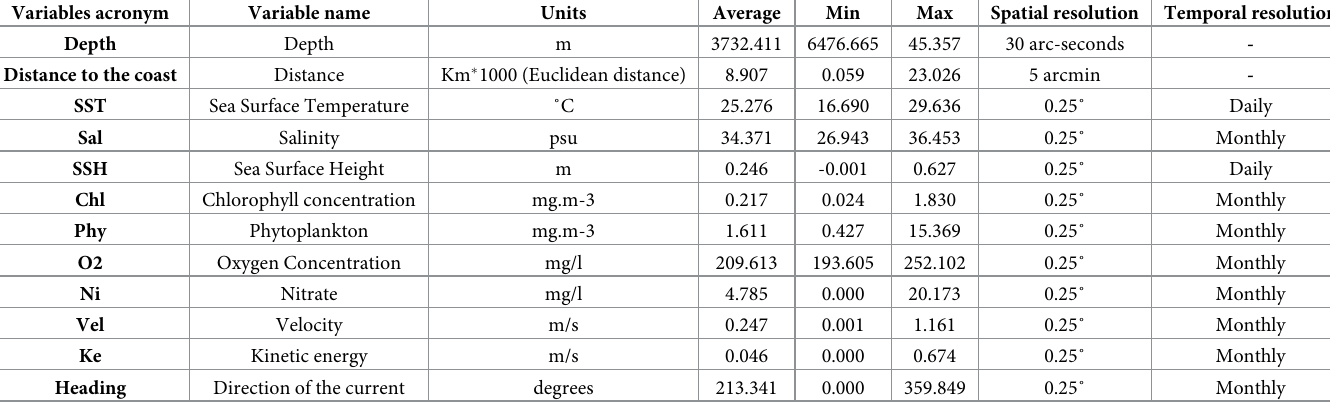
Table 1. Summary of the environmental variables obtained from Copernicus Marine Environment Monitoring Service (CMEMS): Variable acronym and Name, Unit, Average value, Minimimum value, Maximum value, and Spatial and Temporal resolution. Variables